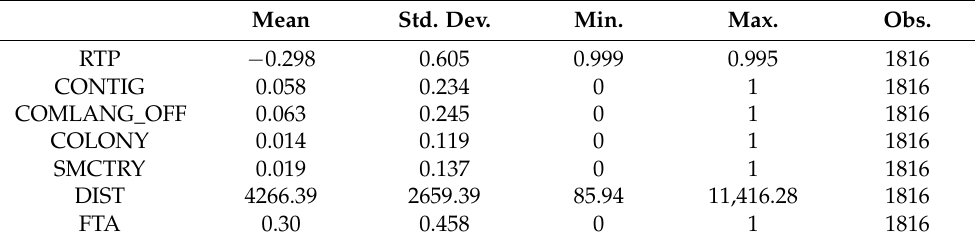
Table 8. Summary statistics of the variables used in Equation